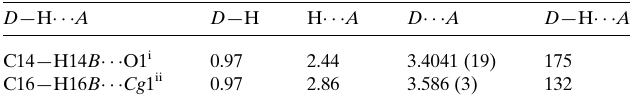
Table 2 Experimental details.